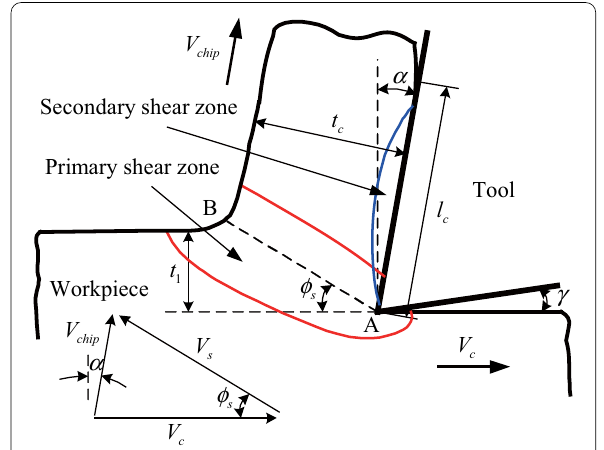
Figure 4 Schematic diagram of the continuous chip formation (chip slipping velocity V chip , shear plane velocity V s ) [81,